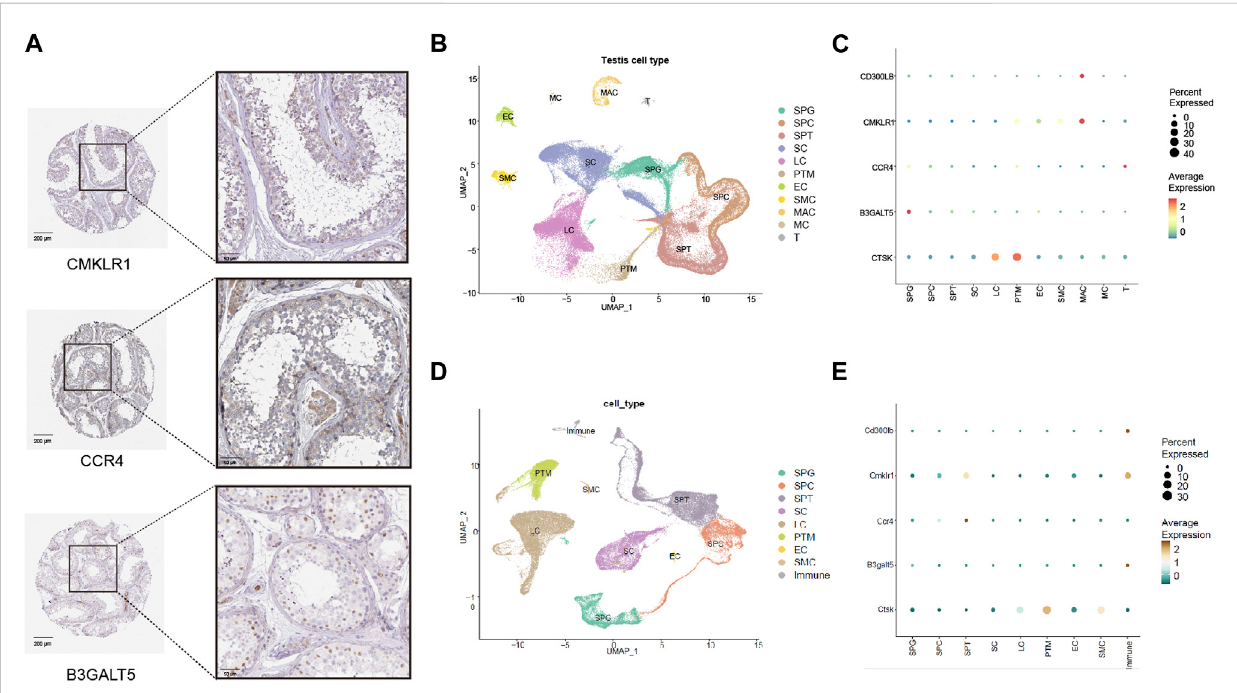
FIGURE 5 Expression patterns of fi ve hub genes ( CD300LB, CMKLR1, CCR4, B3GALT5, and CTSK ) in the testicular tissues and cell types. (A) Immunohistochemistry results of fi ve hub genes for healthy control in the HPA database (scale bars = 50 μ m and 200 μ m). (B) Cell type analysis of testicular cell for healthy male control. (C) Expression patterns of fi ve hub genes categorized by human testicular cell types. (D) Cell type analysis of testicular cell for healthy male mice control. (E) Expression patterns of fi ve hub genes categorized by mouse testicular cell types. HPA: Human Protein Atlas; SPG: spermatogonia; SPC: spermatocyte; SPT: spermatid/sperm; SC: Sertoli cell; LC: Leydig cell; PTM: peritubular myoid cell; EC: Endothelial cell; SMC: vascular smooth muscle cell; MAC: Macrophage; MC: Mast cell; T: T cell; Immune: immune